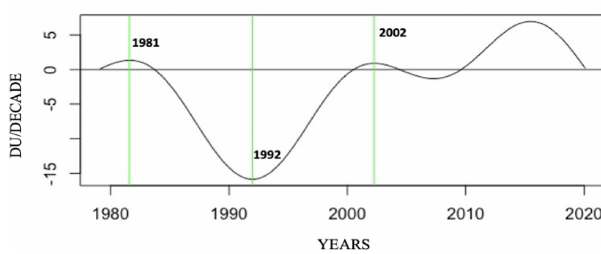
Figure 12. The DU per decade trend returned by the EAWD tech- nique Table 1. Comparison of total ozone variability in Réunion (from 1979 to 2019) obtained with the TREND-RUN model and the EAWD method. IMF